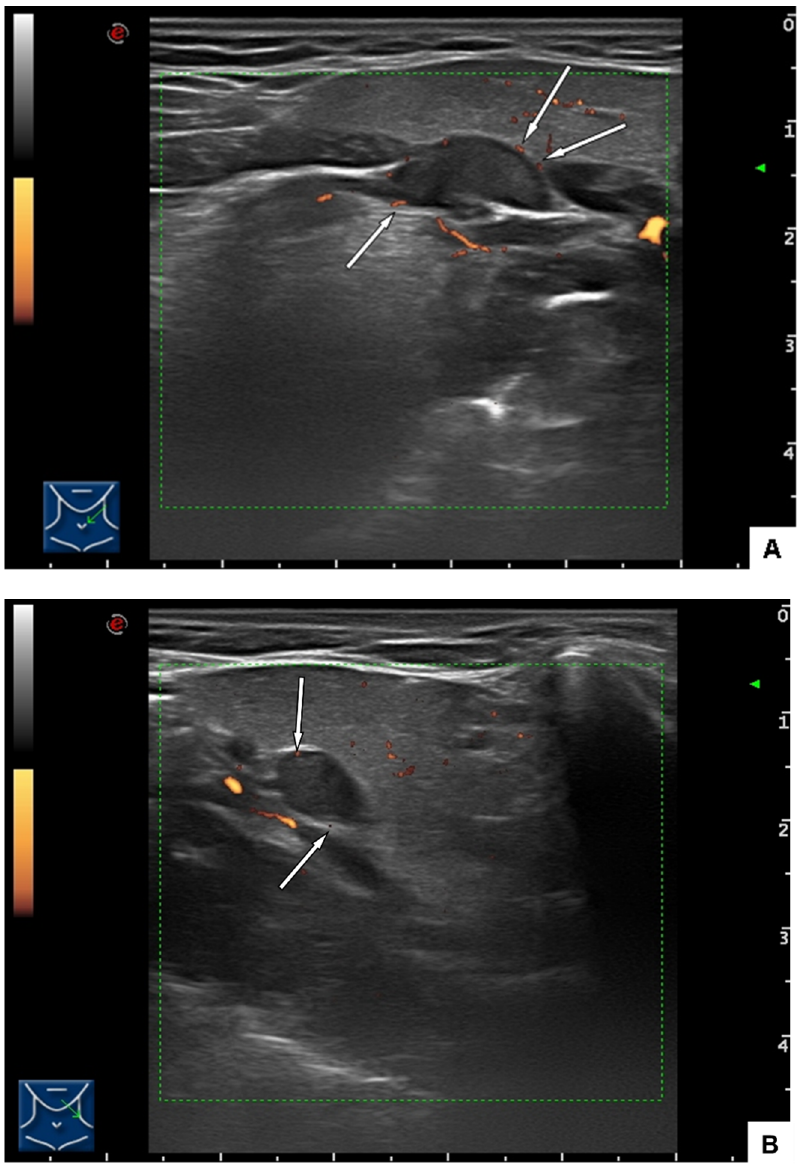
Figure 3 . ( A ) Ultrasound findings: The rather homogeneous tumor is clearly demarcated from the surrounding tissues. Arrows indicate the position of vessels at the tumor surface. ( B ) Transverse view.